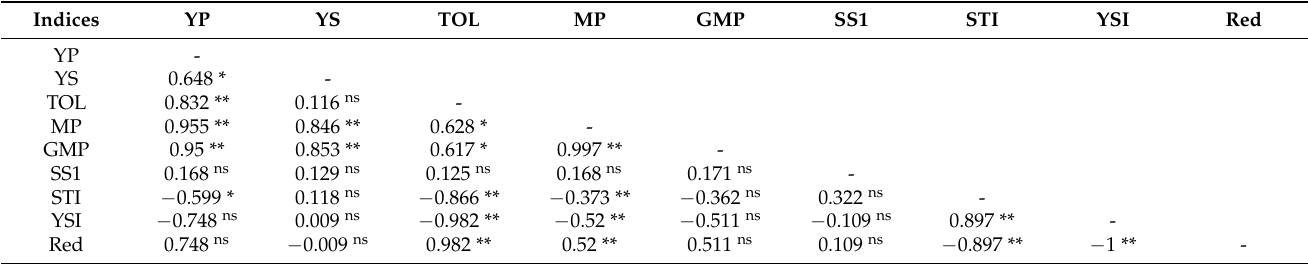
Table 12. Correlation coefficients of drought stress indices and yield under water-irrigated and water-stressed conditions. Indices YP